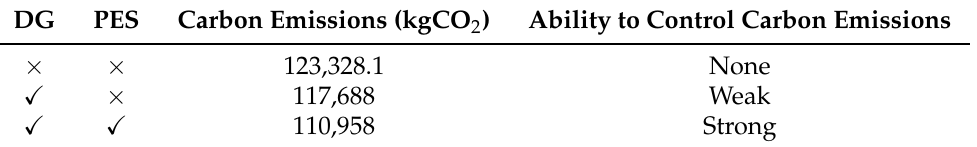
Table 9. Comparison of the three